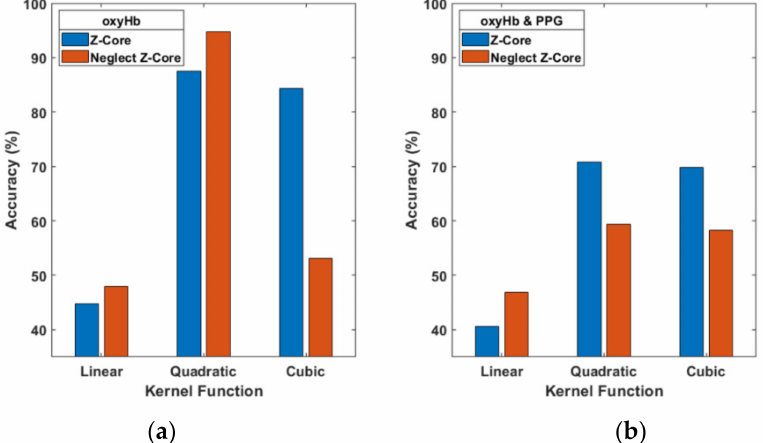
Figure 9. Comparison of the Z-Score and neglect Z-Score for single ( a ) and multiple signals ( b ) and three kernel